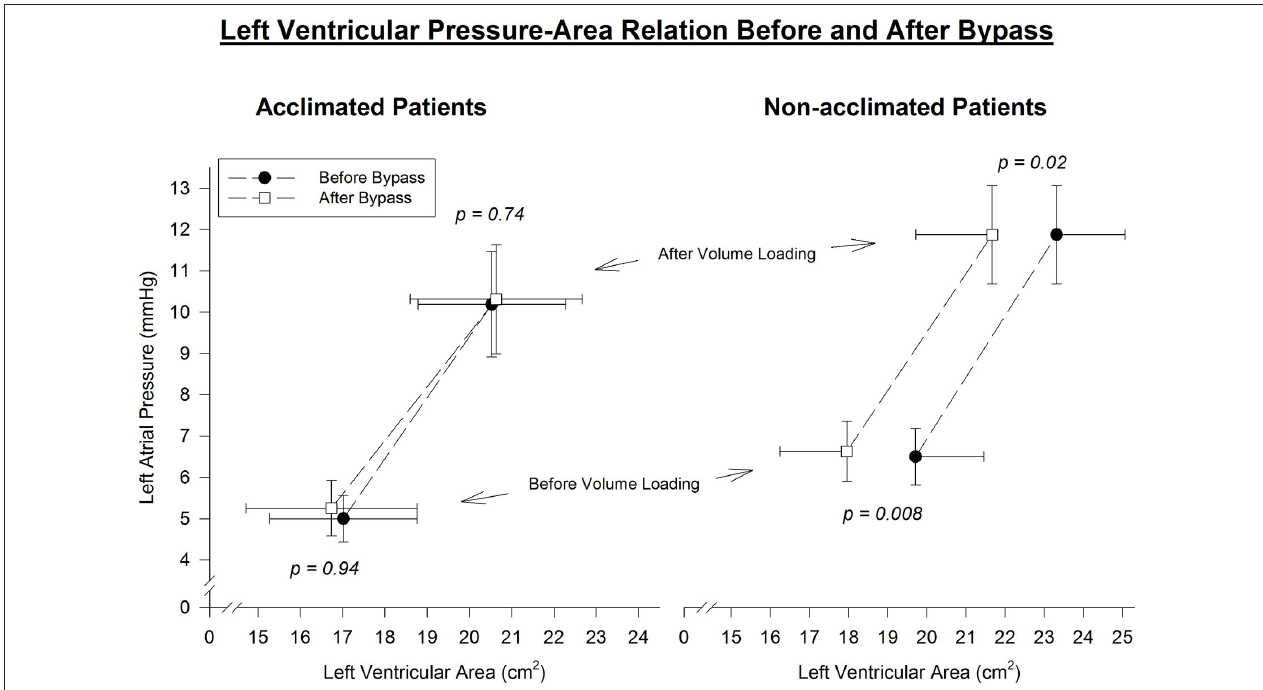
FIGURE 2 | Left ventricular end-diastolic pressure-area relation before and immediately after cardiopulmonary bypass. Pre- and post-bypass left-ventricular area is compared at similar left-atrial pressure throughout the range of volume manipulation. A parallel leftward shift of the pressure-area curve is evident in non-acclimatized patients, consistent with reduced left-ventricular diastolic distensibility after bypass. In contrast, the slope and position of the pressure-area curve is maintained after bypass in acclimatized patients, indicating no significant change in left-ventricular diastolic